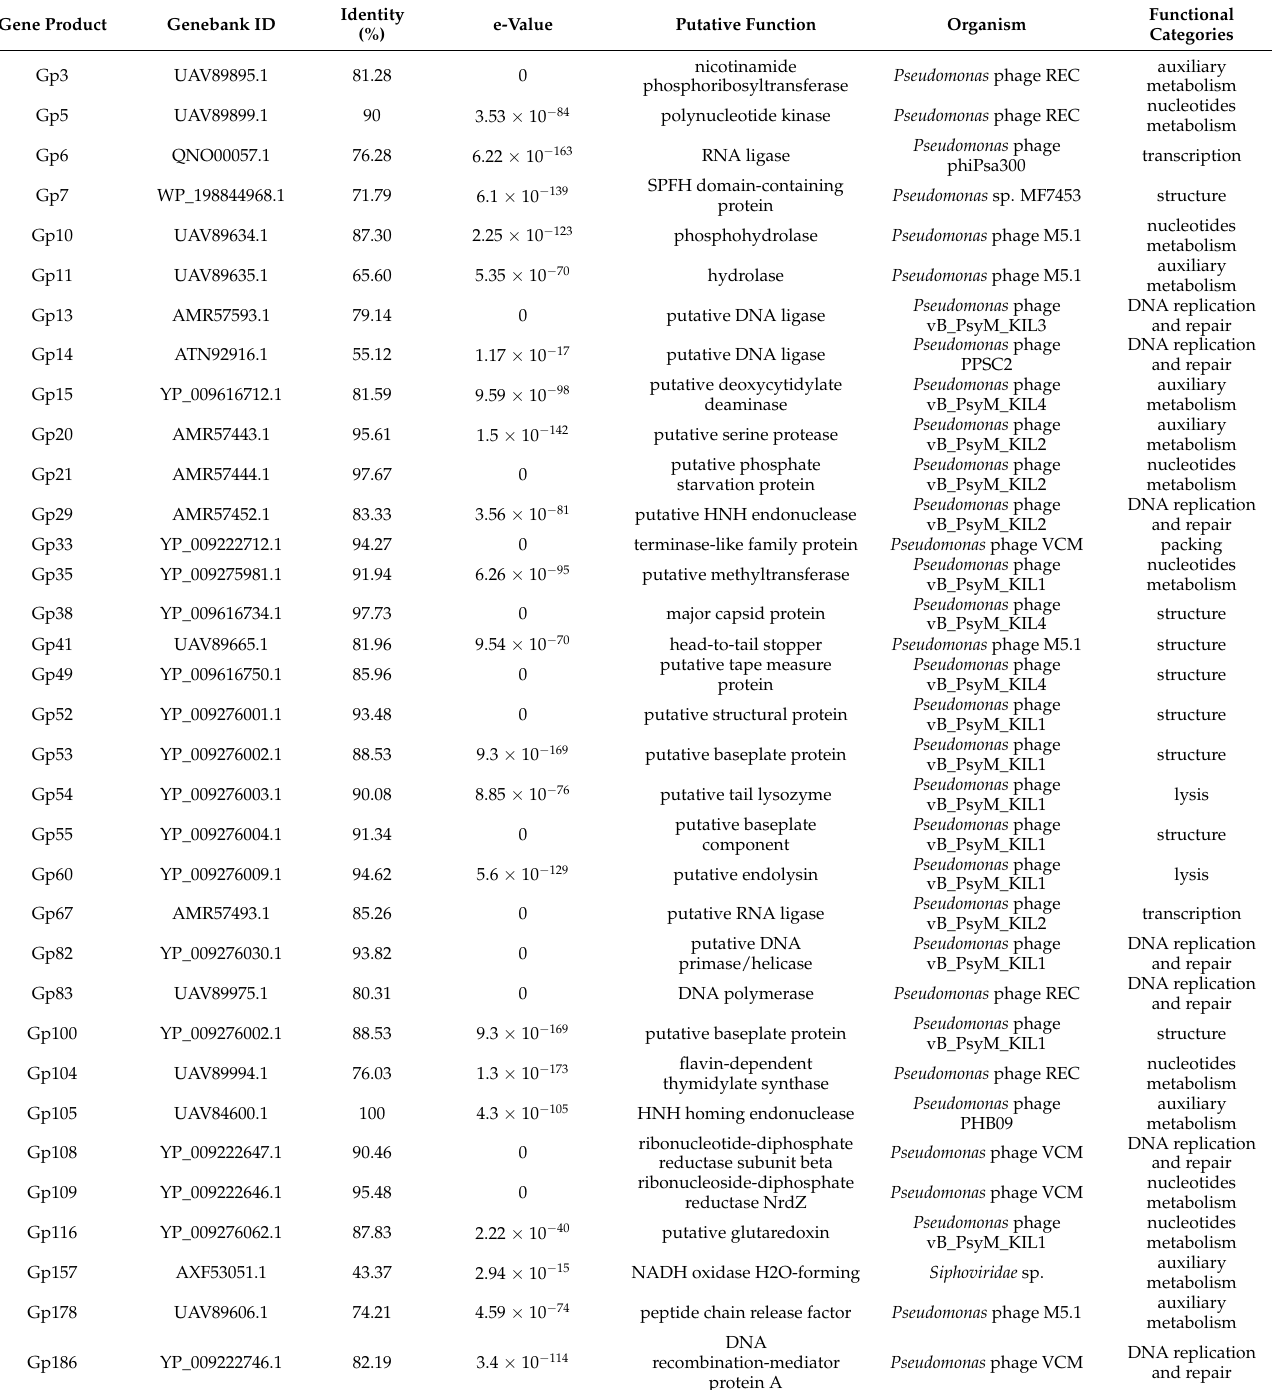
Table 3. Gene similarities of